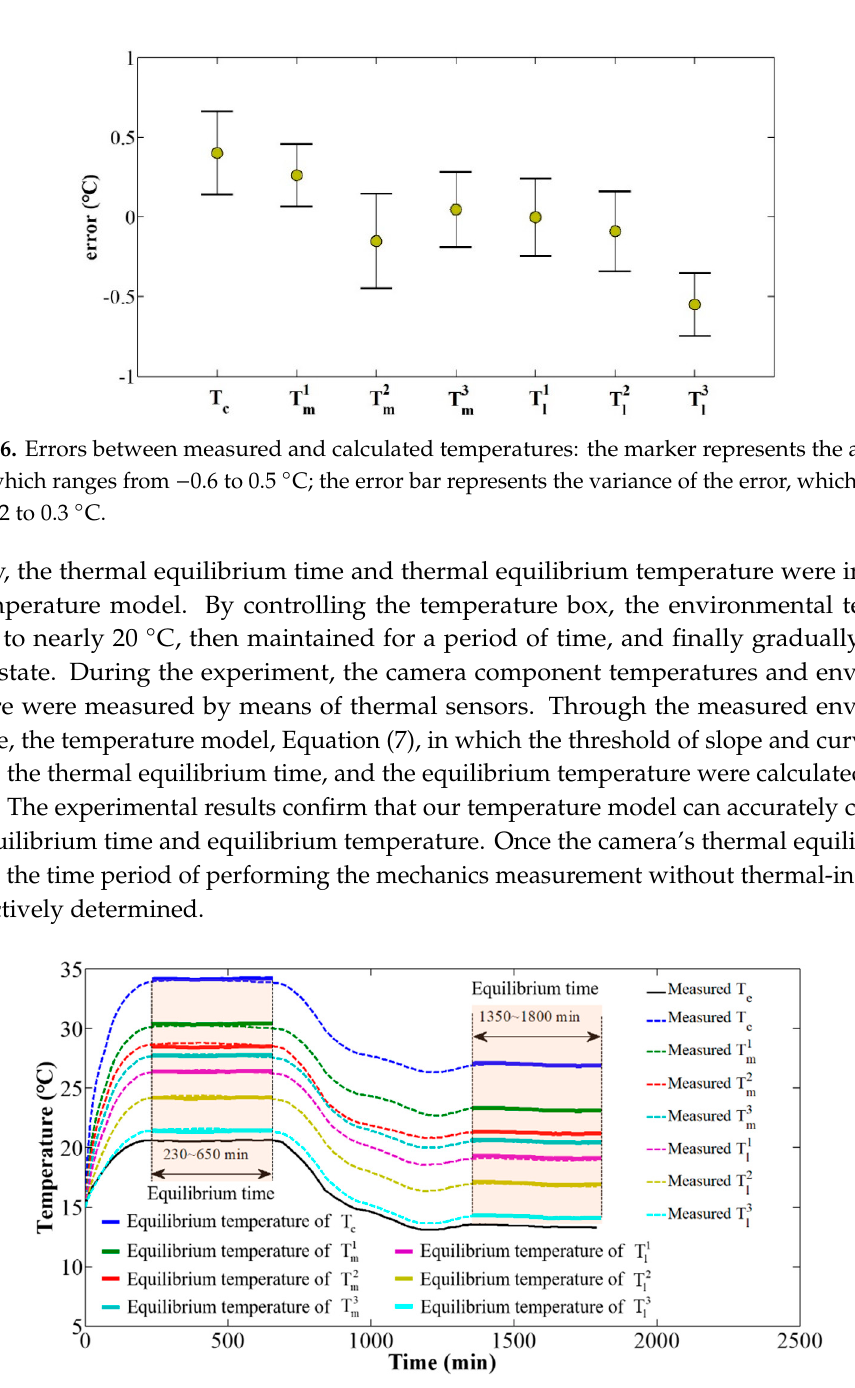
Figure 7. Calculated thermal equilibrium time and equilibrium temperature: in the first equilibrium time (230 to 650 min), the equilibrium temperatures of the target points on the camera are 34.2, 30.4, 28.4, 27.7, 26.4, 24.2, 21.4 °C, respectively; in the second equilibrium time (1350 to 1800 min), the equilibrium temperatures are 27.0, 23.2, 21.3, 20.5, 19.2, 17.0, 14.2 °C, respectively.